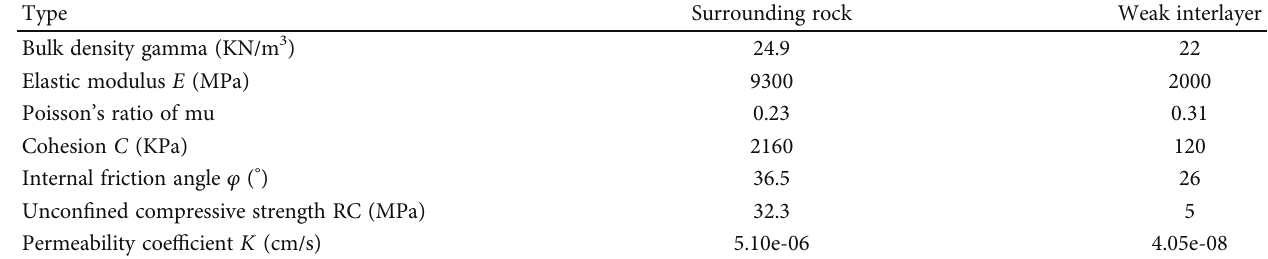
Table 1: Physical parameters of surrounding rock and weak interlayer.